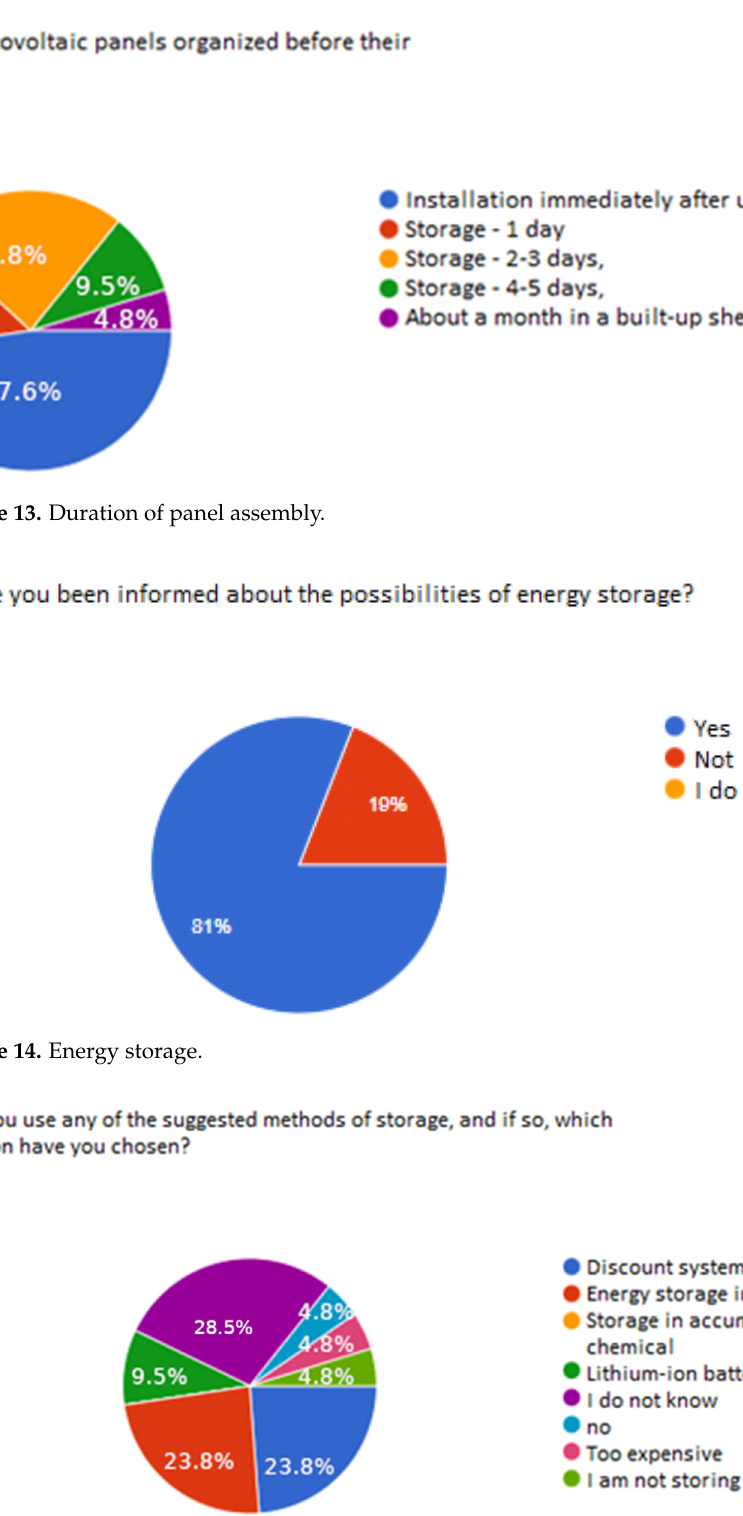
Figure 12. Place of installation of photovoltaic panels.